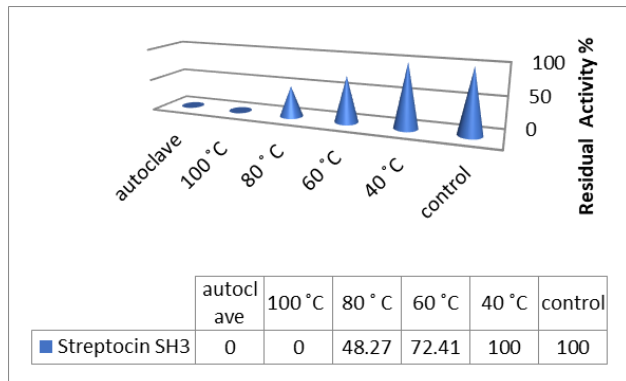
Figure. 4: Thermal stability of streptocin SH3